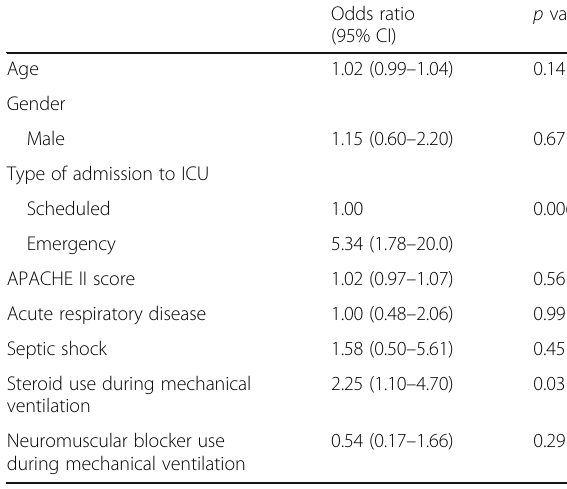
Table 2 Multivariable logistic regression analysis for